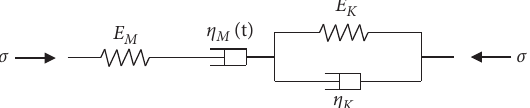
Figure 6: Normal compression creep model of the fractured rock mass.